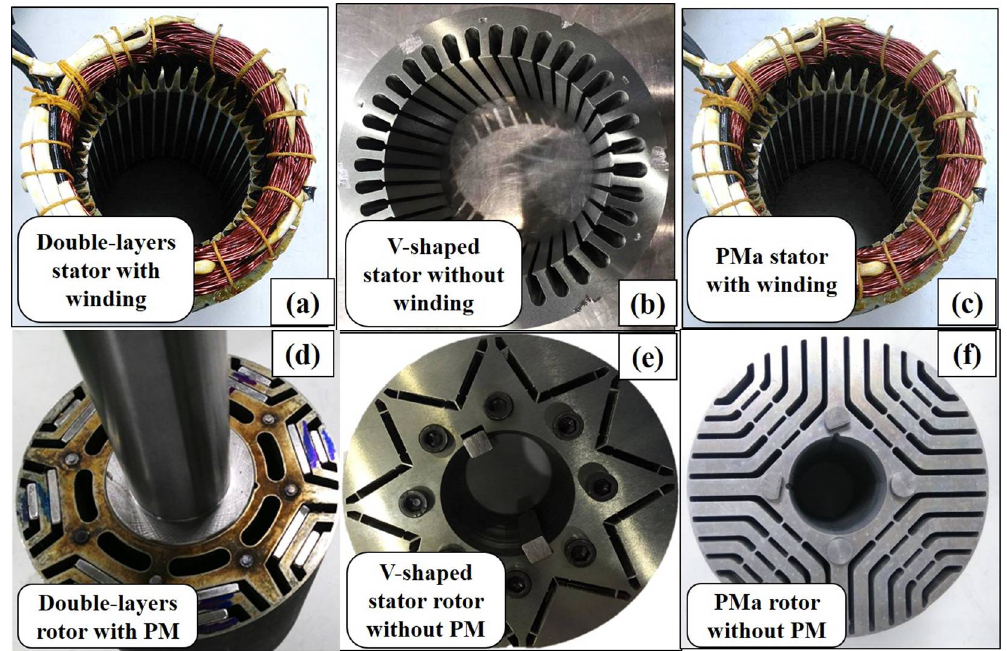
Figure 21. Prototypes of IPMSMs and PMa-SynRM: ( a ) stator of double-layers IPMSM with winding, ( b ) stator of V-Shaped IPMSM without winding, ( c ) stator of PMa-SynRM with winding, ( d ) rotor of double-layers IPMSM with PM, ( e ) rotor of V-shaped IPMSM without PM, and ( f ) rotor of PMa-SynRM without PM.